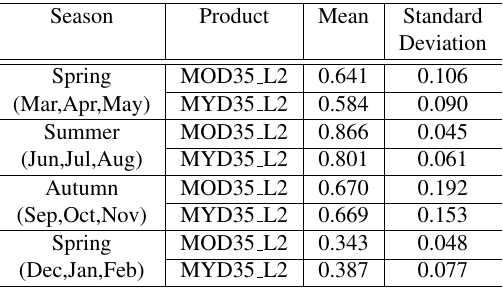
Table 2. Clear sky ratio derived from MOD35 L2